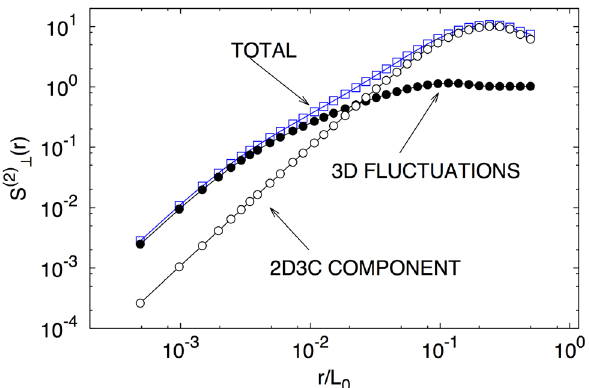
FIG. 6. Log-log plot of the second-order Eulerian transverse structure function in the plane perpendicular to the rotation axis, S ð 2 Þ r Þ , for N ¼ 2048 and Ω ¼ 10 . Whole field u ð x; y; z Þ ⊥ ð y; z Þ component (empty circles), (squares), to the 2D3C u 2 D ð and to the fluctuating 3D component u 0 ð x; y; z Þ (filled